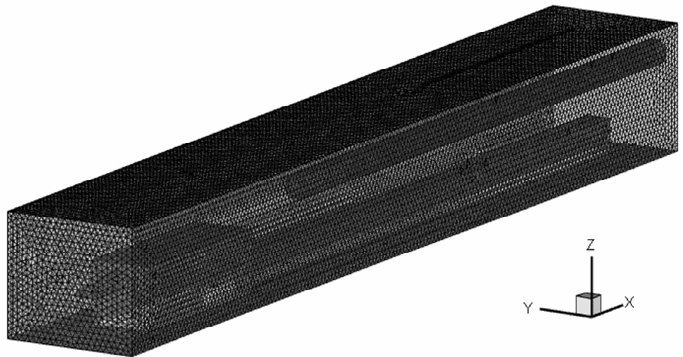
Figure 4. Mesh Figure 4. Mesh generation.